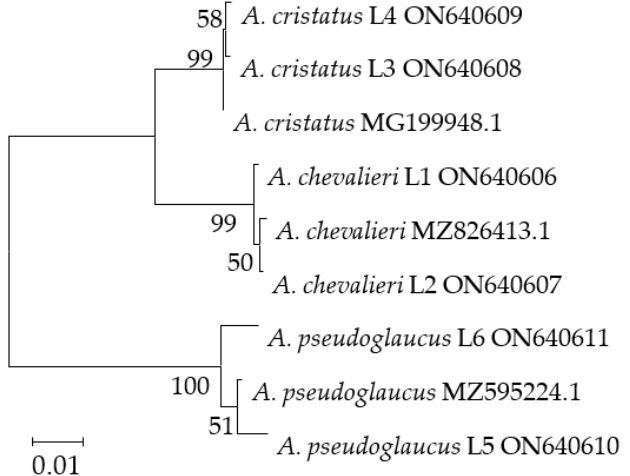
Figure 2. Neighbor-Joining phylogeny tree derived from Aspergillus spp. BenA sequences.